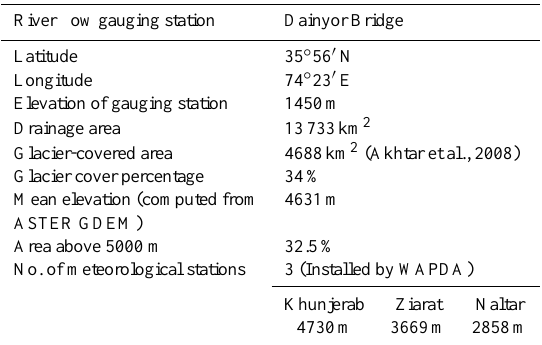
Table 1. Characteristics of the study area (Hunza River